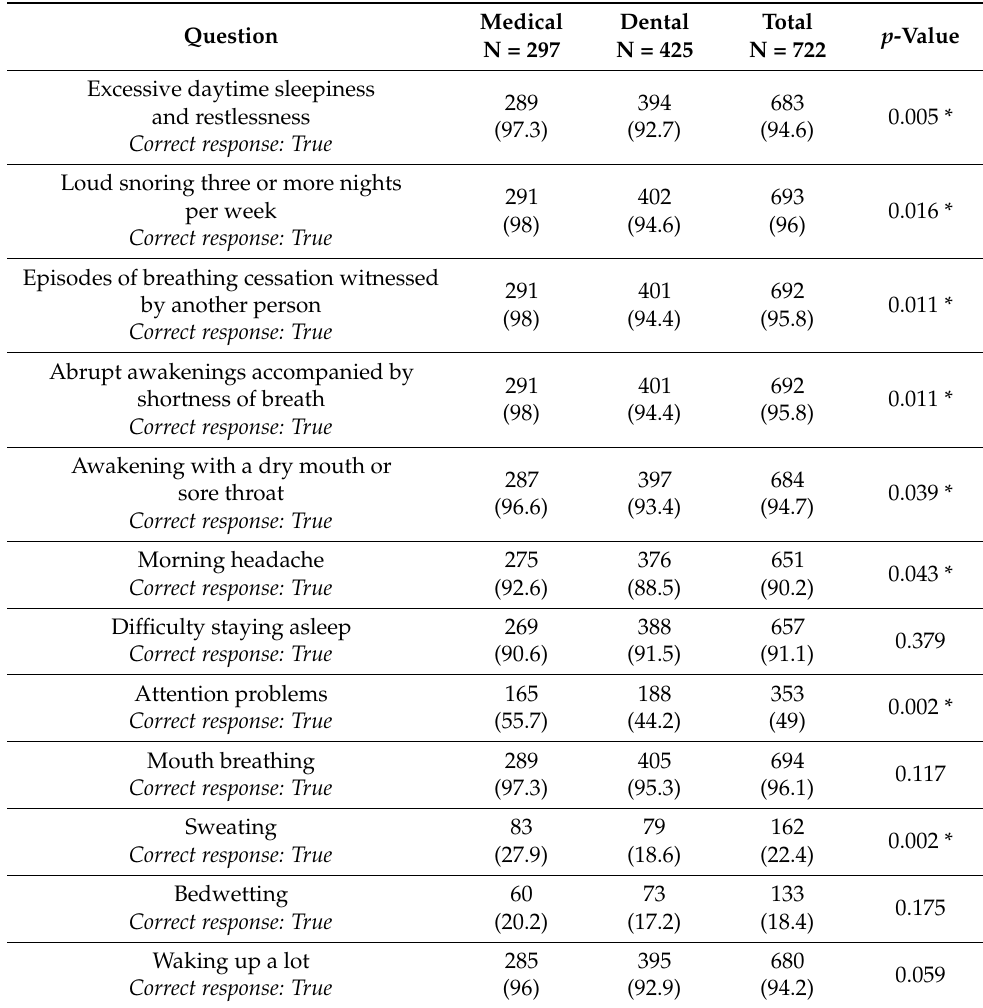
Table 2. Frequency (percentage) of the correct answer in questions about signs and symptoms of pediatric